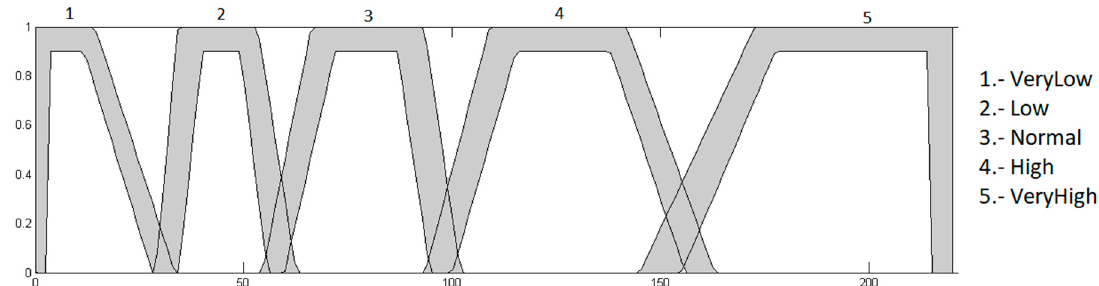
Figure 12. Age input with trapezoidal MFs.